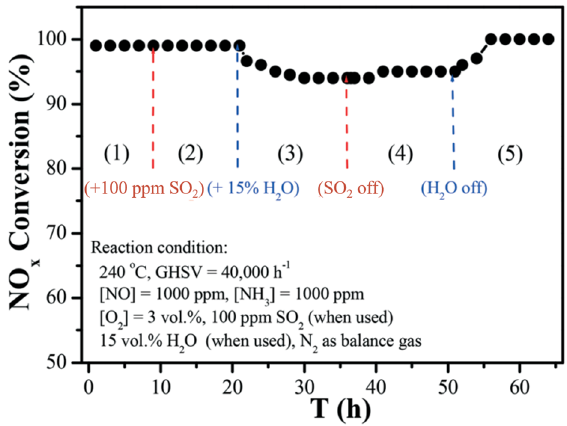
Figure 33. Effects of H 2 O and SO 2 on NO x conversion over the Ni 0.4 Mn 0.6 Ti 10 catalyst. (Reproduced with permission from Reference [47], Copyright 2017,The Royal Society of Chemistry.).